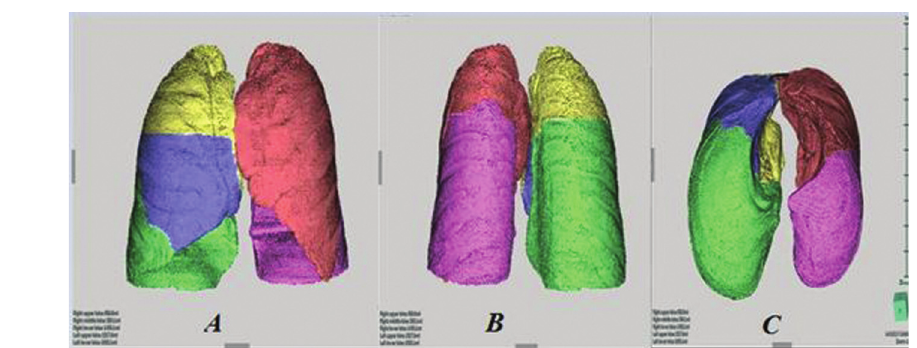
One of our patients, a male of 55 years, who was a smoker presented for follow-up of emphysema. 3D color-coded images of the lung using CT volumetry with each lobe having a specific color. The lung can be visualized in different axis planes, for example, (a) anterior view, (b) posterior view, and (c) inferior (caudal) oblique view. The volume of each lobe is